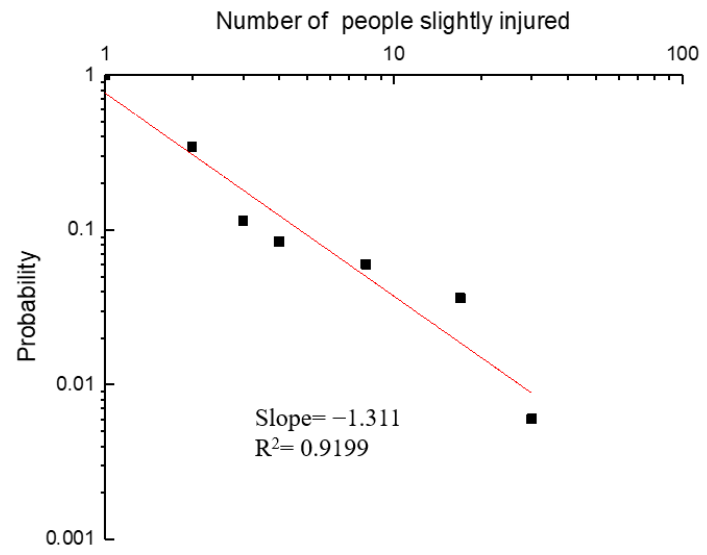
Figure 7. Accumulated probability of an accident with N slightly injured.